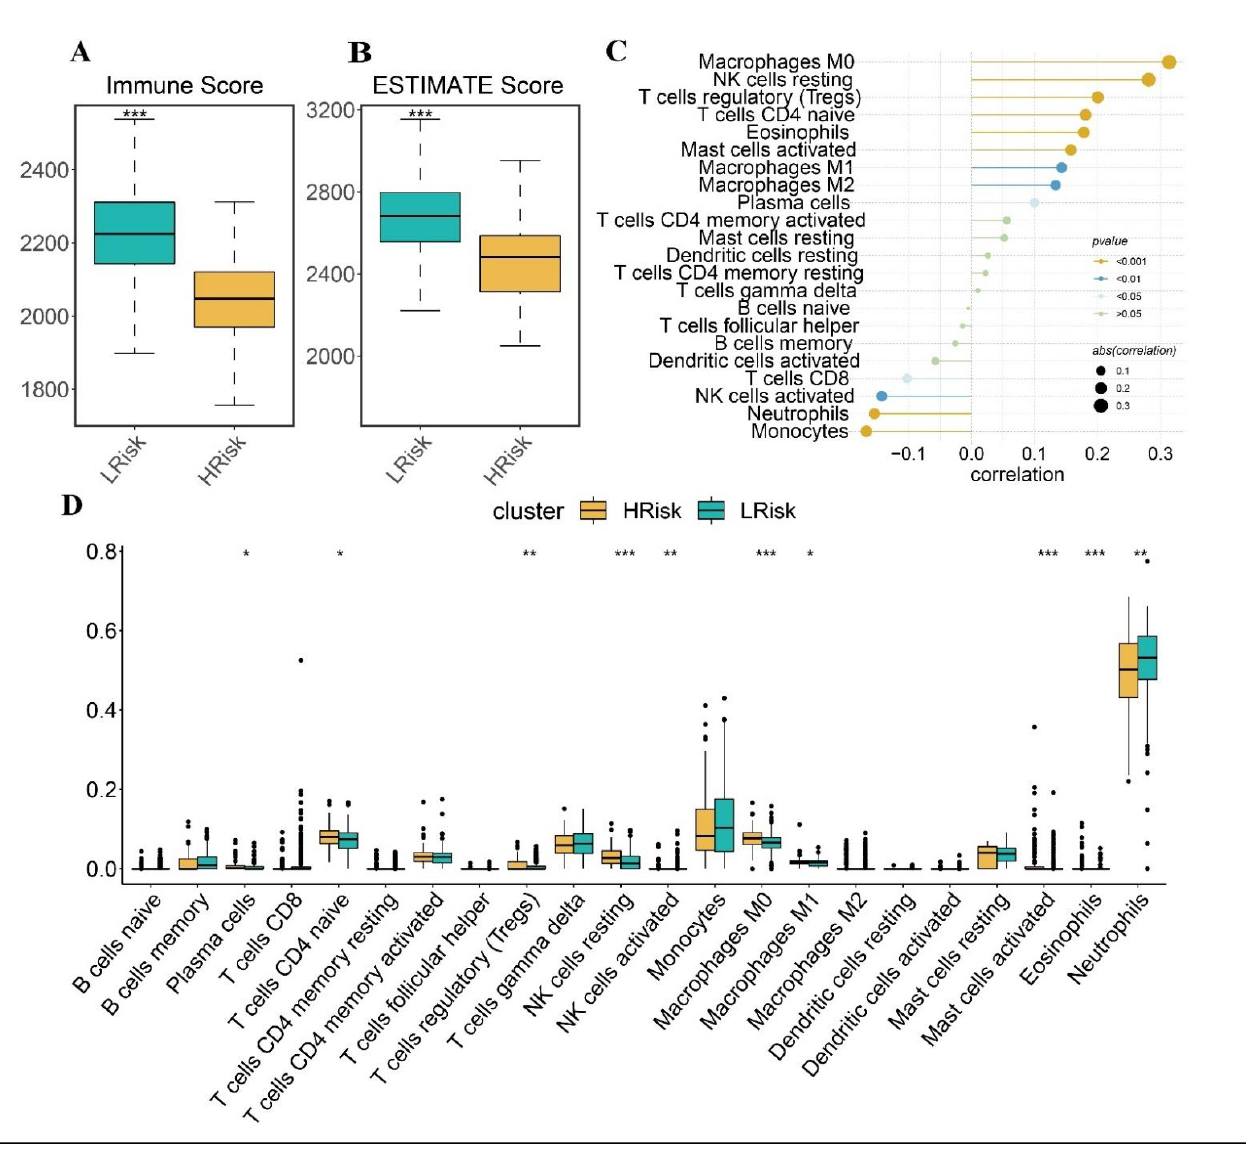
Figure 4. The different immune profiles between the low- and high- risk groups in the GSE65682 dataset. Two risk groups were divided based on the median risk score. ( A ) Immune score. ( B ) ESTI- MATE score. ( C ) Correlation between risk score and ( D ) immune cell content. p values were showed as: ns not significant; * p < 0.05; ** p < 0.01; *** p <